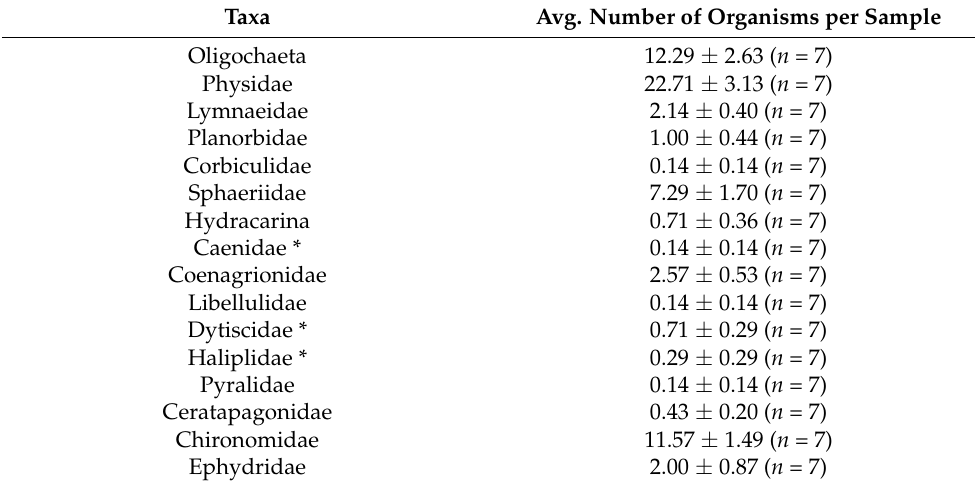
Table 1. The average number ( ± standard error) of organisms by taxa in reserved subsamples used to seed mesocosms in July